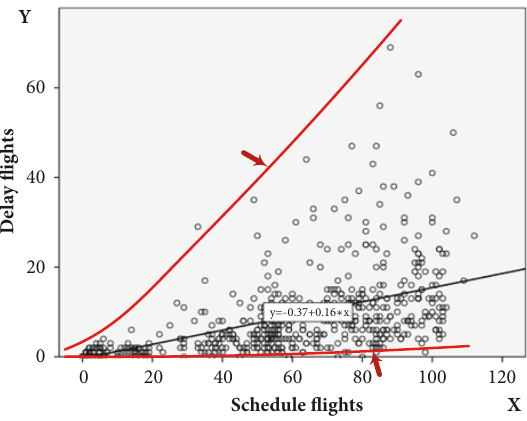
Figure 1: Scatter diagram of delay flights and schedule flights.